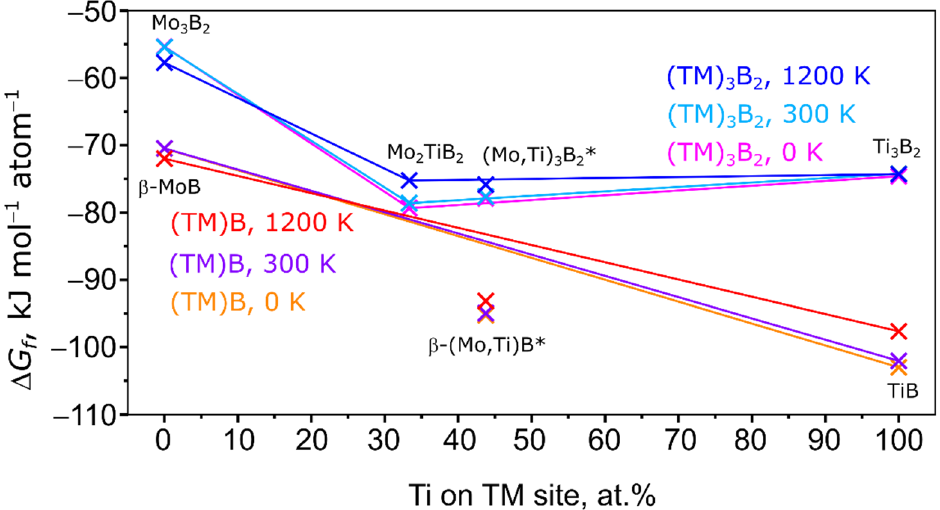
Figure 8. Enthalpy of formation of the (ΤΜ) B and (TM) 3 B 2 (TM = Mo, Ti) series at 0, 300, and 1200 K. 0 at.% Ti: β -MoB and Mo 3 B 2 , 33.3 at.% Ti: Mo 2 TiB 2 , 43.75 at.% Ti: SQS cells of β -(Mo,Ti)B and (Mo,Ti) 3 B 2 , 100 at.% Ti: TiB and Ti 3 B 2 . Solid lines serve as a guide to distinguish stable (below that line) and unstable (above that line) disordered phases. *: SQS